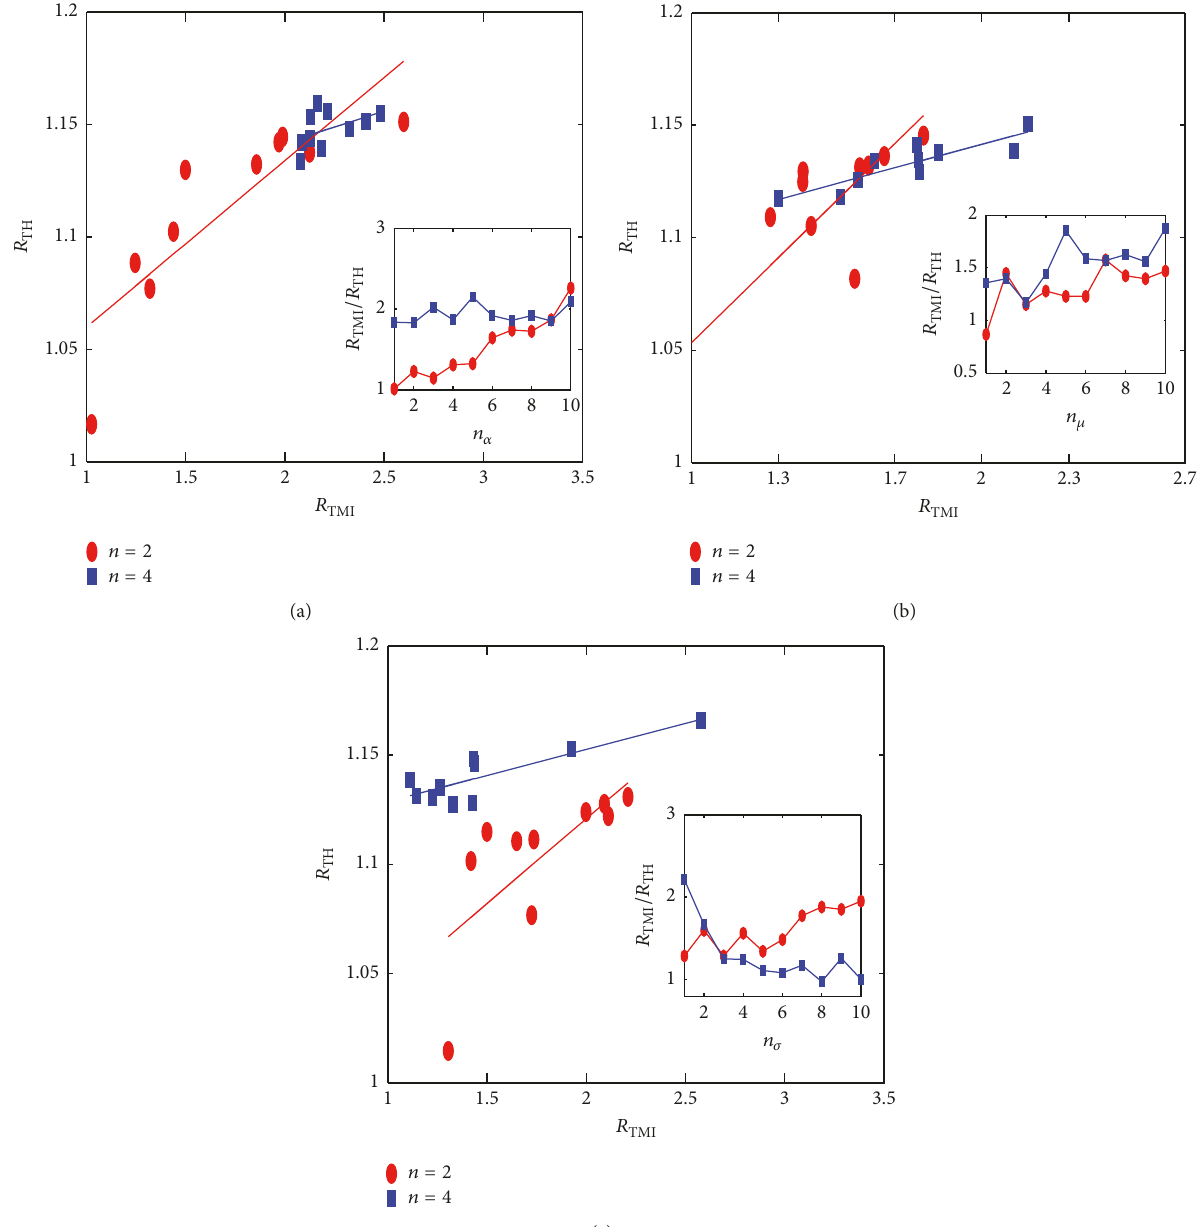
Figure 7: Relation between relative uncertainty and relative